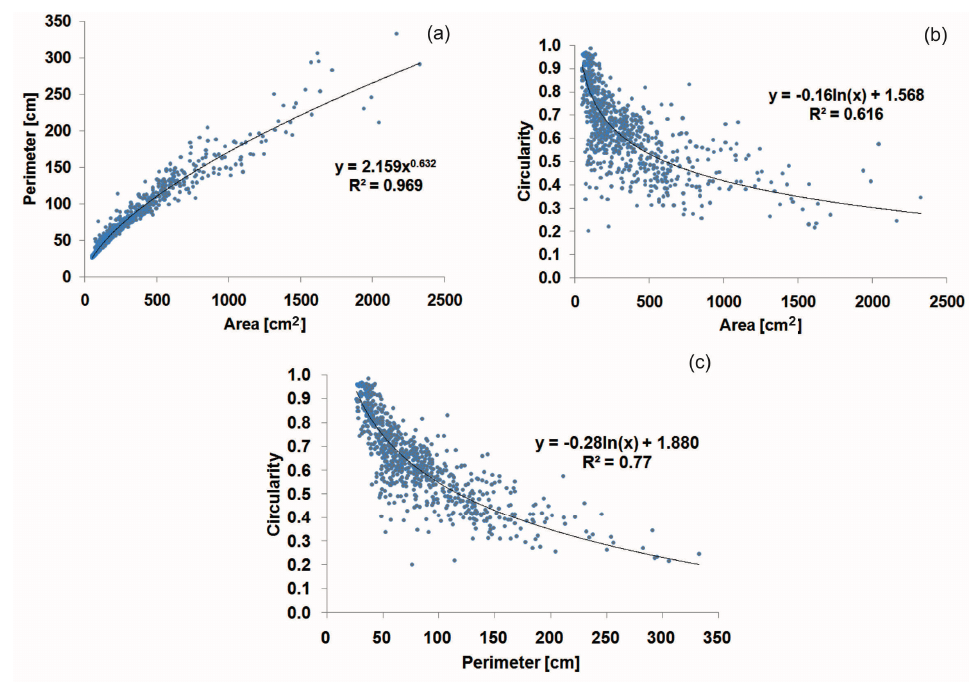
Figure 7. Correlations between the bioerosion features variables. ( a ) Area and perimeter; ( b ) Area and circularity; ( c ) Perimeter and